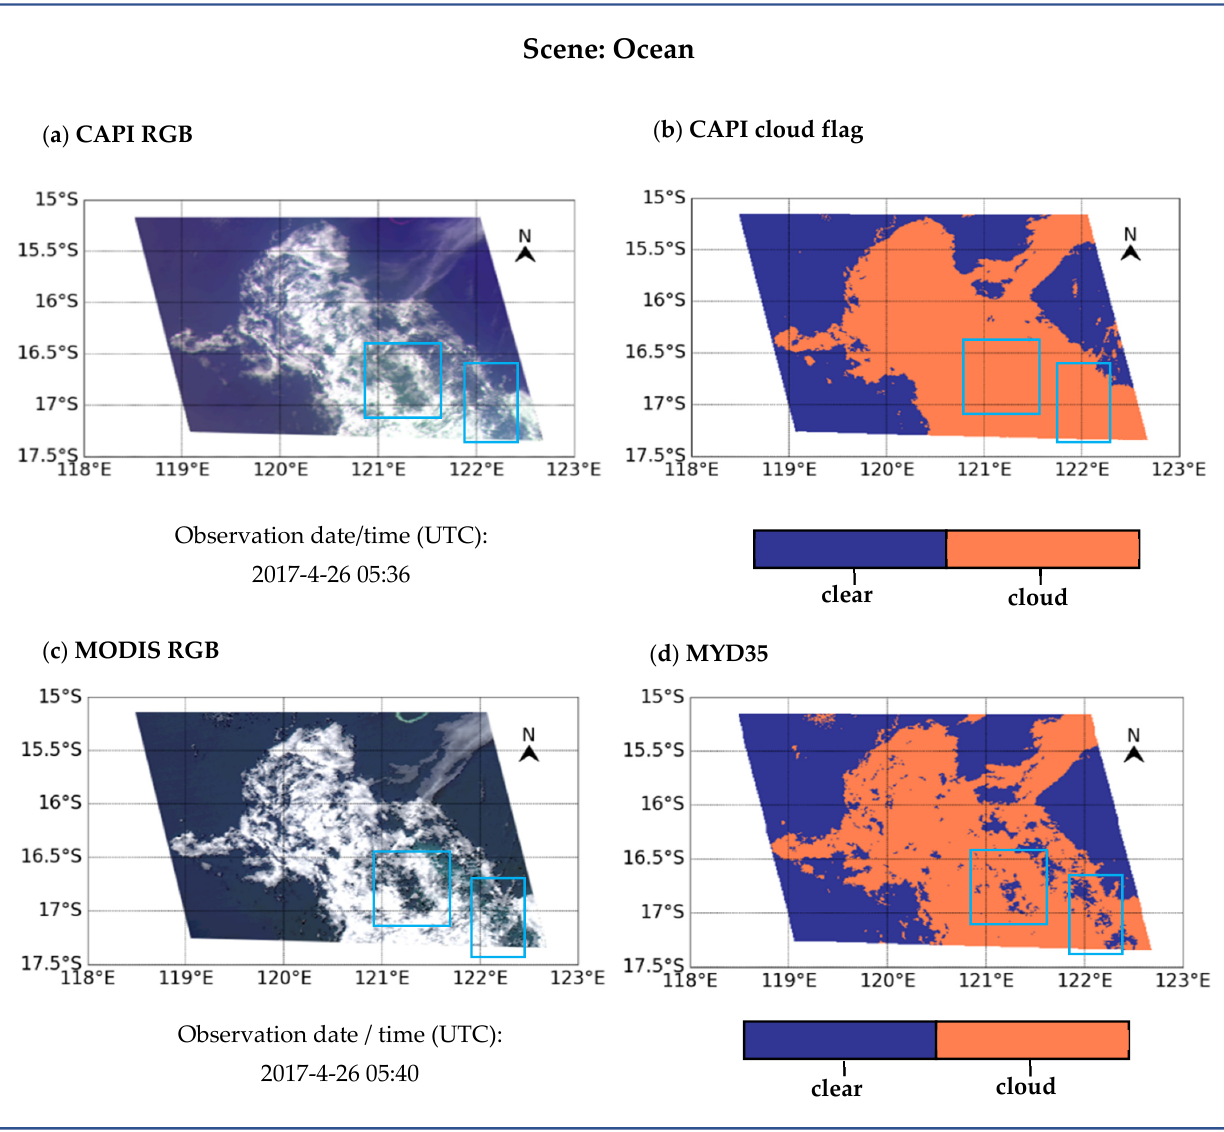
Figure 4. Case over the northwest coast of Australia and Indian ocean at 05:36 UTC 26 April 2017 for CAPI and at 05:40 UTC 26 April 2017 for MODIS. The “time” is the start time when the imager took the image of this scene. ( a ) The CAPI false color image, ( b ) the cloud flag image of CAPI derived by applying NNDT algorithm, ( c ) the MODIS true-color image overlapping with the CAPI scene, and ( d ) the cloud flag of MYD35 with only “cloud” and “clear” results. The cloud detection results for a scene over the Antarctic continent are shown in Figure 8. For pixels covered with snow and/or sea ice, it is generally difficult to distinguish clear sky and clouds because they have a visual feature and spectrum similar to clouds, namely, white with high reflectance. Comparison with the CAPI RGB image suggests that our algorithm can accurately distinguish between clear sky and cloudy areas over the bright snow and ice surface. The NNDT algorithm identifies the cloud anti bright edge as cloud and the cloud shadow as clear sky. It shows the sensitivity and accuracy of NNDT algorithm in distinguishing cloud anti bright edge from surface and cloud shadow from cloud. In addition, for pixels with high and thin cloud distribution, MYD35 is identified as clear sky, while NNDT algorithm can accurately identify them as